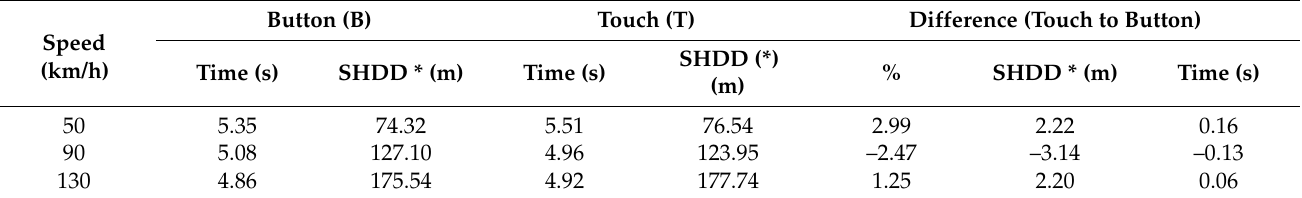
Table 5. SHD values and